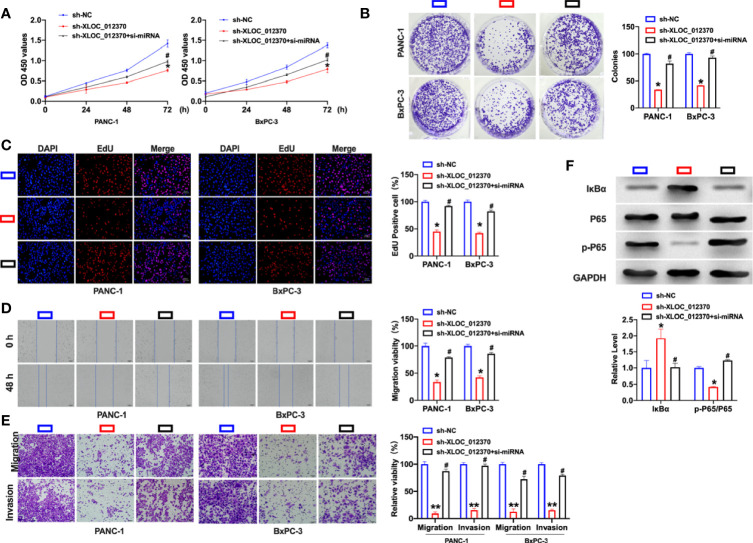
XLOC_012370 regulates tumor progression via targeting miR-140-5p. (A) The cell viability of PANC-1 and BxPC-3 cells were detected by CCK-8 assays. n=5, *P < 0.05, #
P < 0.05. (B) Colony formation was counted in PANC-1 and BxPC-3 cells. n=3, *P < 0.05, #
P < 0.05. (C) Representative images and histogram analysis of EdU assays in PANC-1 and BxPC-3 cells. n=3, *P < 0.05, #
P < 0.05. (D) Wound healing assays in PANC-1 and BxPC-3 cells. n=3, *P < 0.05, #
P < 0.05. (E) Representative images and histogram analysis of transwell assays in PANC-1 and BxPC-3 cells. n=3, *P < 0.05, #
P < 0.05. (F) The protein level of IκBα, P65, and p-P65 was detected in PANC-1 cells. n=4, *P < 0.05, #
P < 0.05, **P < 0.01.